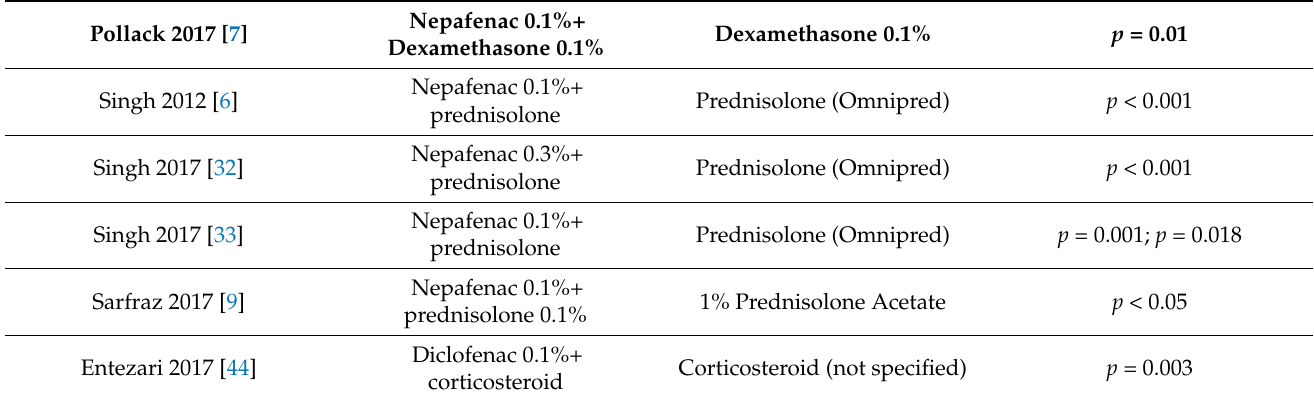
Table 3. PCME prevention studies comparing the combination of NSAIDs and corticosteroids with corticosteroid monotherapy in NPDR